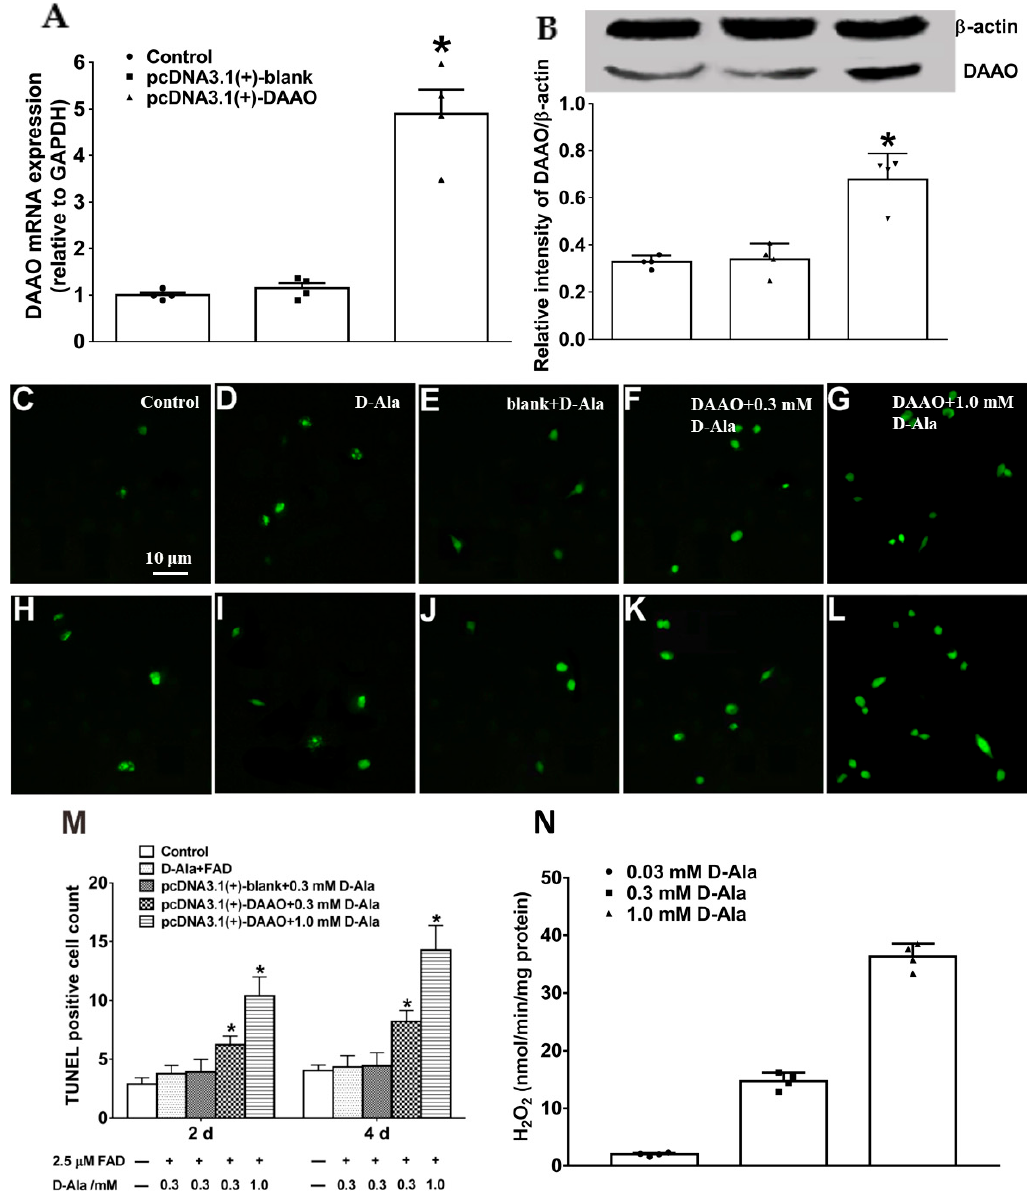
Figure 5. DAAO overexpression promotes hippocampal neuronal death. ( A , B ) Evaluation of pcDNA3.1(+)- daao transfection and DAAO expression at both mRNA and protein levels. The transfected astrocytes were collected using a cell scraper. The concentration of total protein extracted from cells with lysis solution was determined using the bicinchoninic acid protein method. ( C – L ) Apoptotic neurons were detected using a fluorescent TUNEL assay kit at different timepoints (2 d: ( C – G ) and 4 d: ( H – L )). ( M ) Cell apoptosis was quantitatively analyzed with Im- ageJ software. ( N ) The H 2 O 2 level was measured as the byproduct of different concentrations of D-Ala in pcDNA3.1(+)- daao -transfected astrocytes after enzymatic reaction for 30 min. Data are expressed as means ± SEM ( n = 4). * denotes statistical significance ( p < 0.05) compared with pcDNA3.1(+)-blank+0.3 mM D-Ala group, as calculated by one-way ANOVA and post hoc Stu- dent–Newman–Keuls tests ( M ) or unpaired two-tailed Student’s t -test ( A , B ).